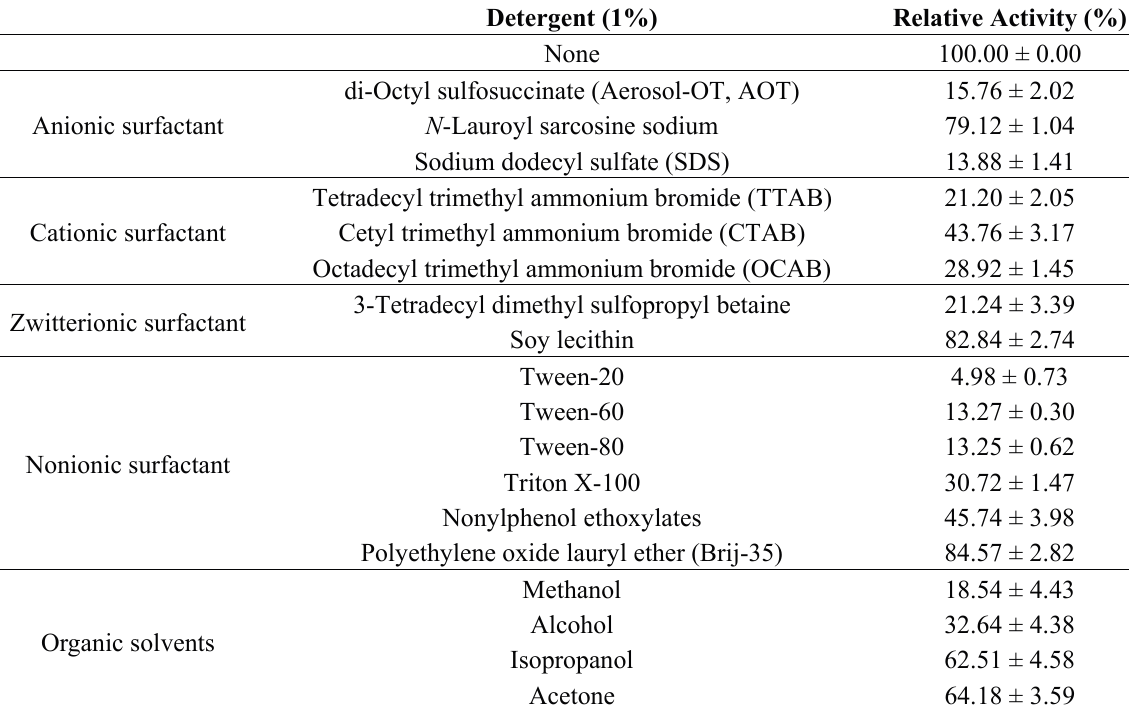
Table 2. Effect of various detergents and organic solvents on the enzyme activity of